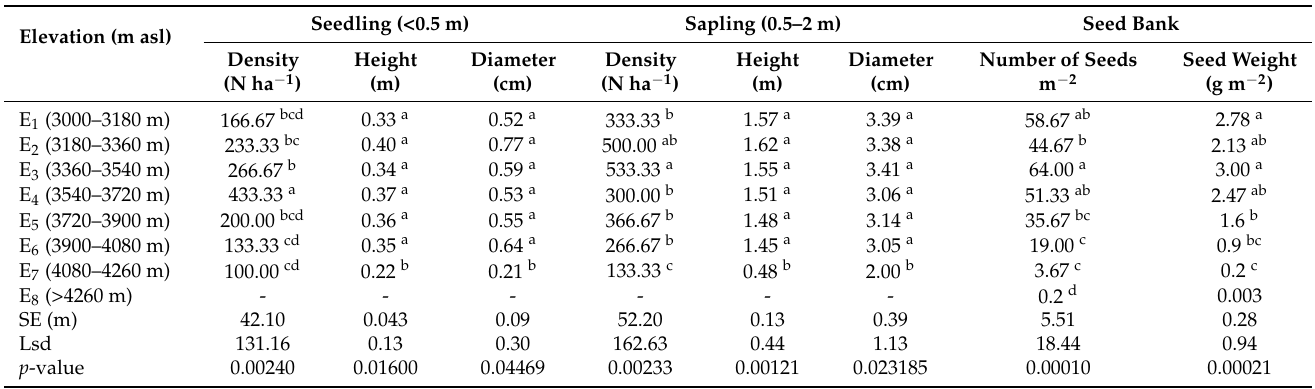
Table 1. Regeneration status and seed bank at different elevational ranges in cold desert of north- western Himalaya.